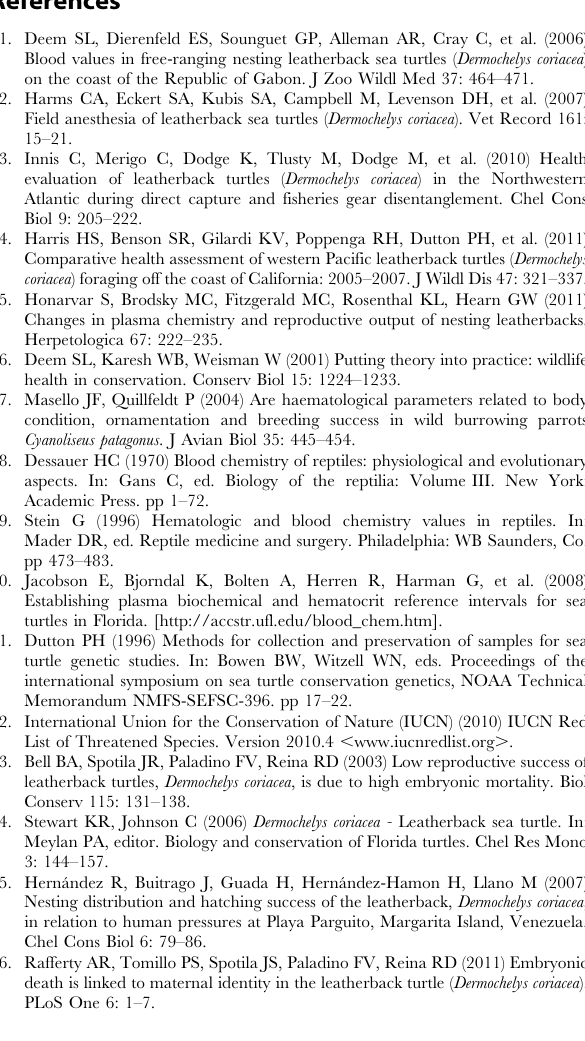
Table S1 Synopsis of hematologic values for leatherback sea turtles from the literature (Pacific Ocean). Table S2 Synopsis of plasma biochemical data for leatherback sea turtles from the literature (western Atlantic Ocean).